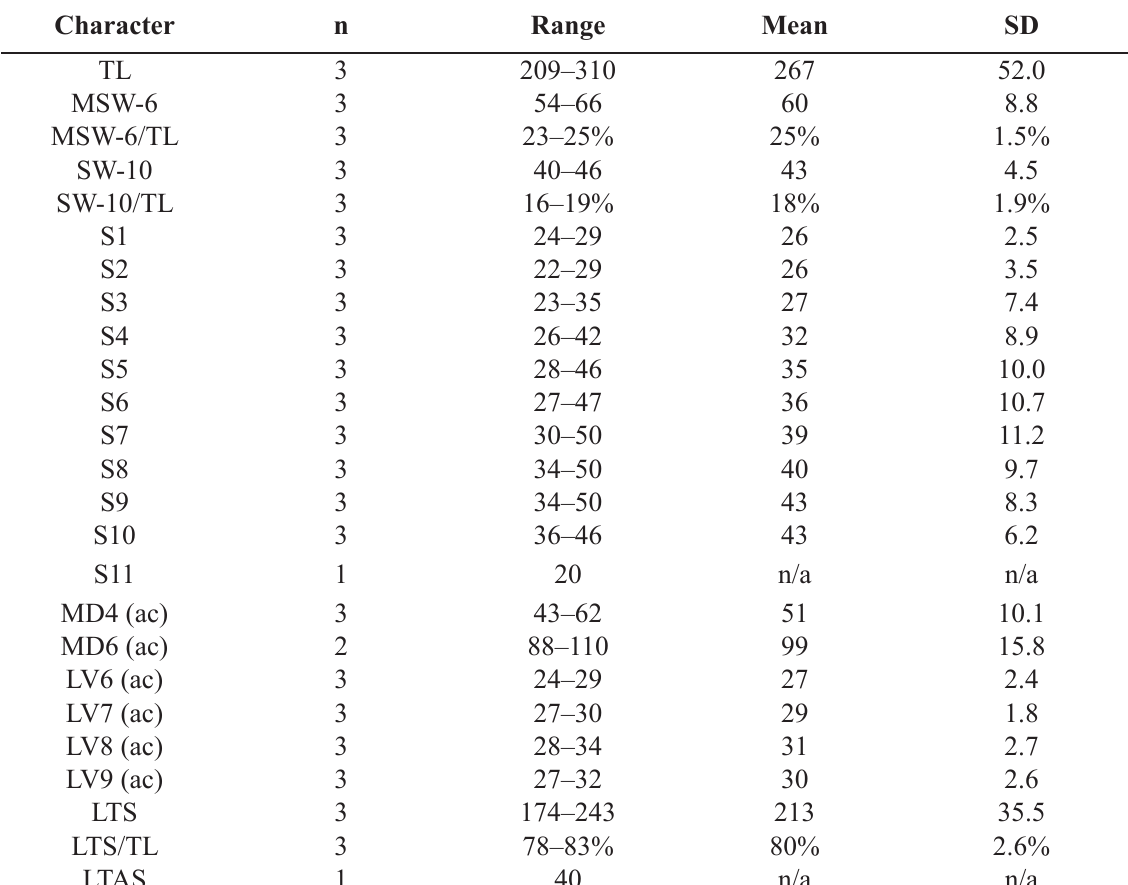
Table 6. Measurements from light microscopy of Echinoderes dalzottoi sp. nov . (in µm) from the Hikurangi Margin, including number of measured specimens (n) and standard deviation